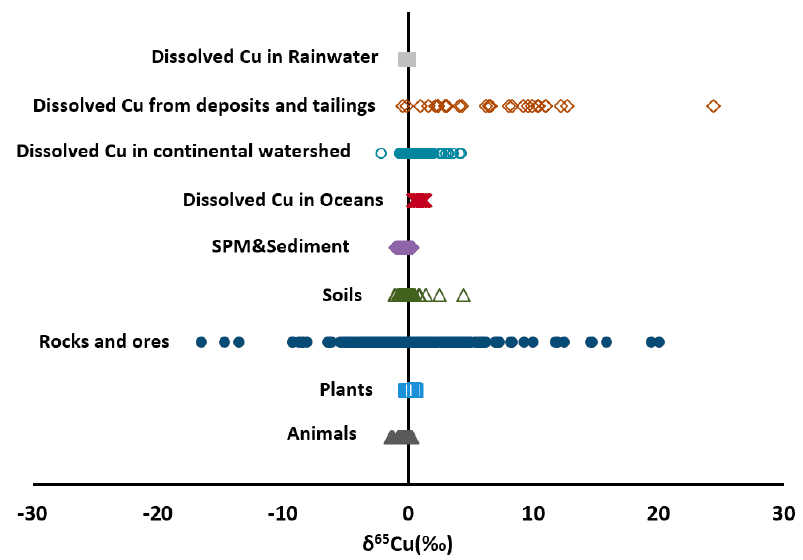
Figure 2. The δ 65 Cu ( ‰ ) values of various natural materials [6,7,15,19–21,26,32,40,59,61,63–66,68,70,72,73,76,80–93].